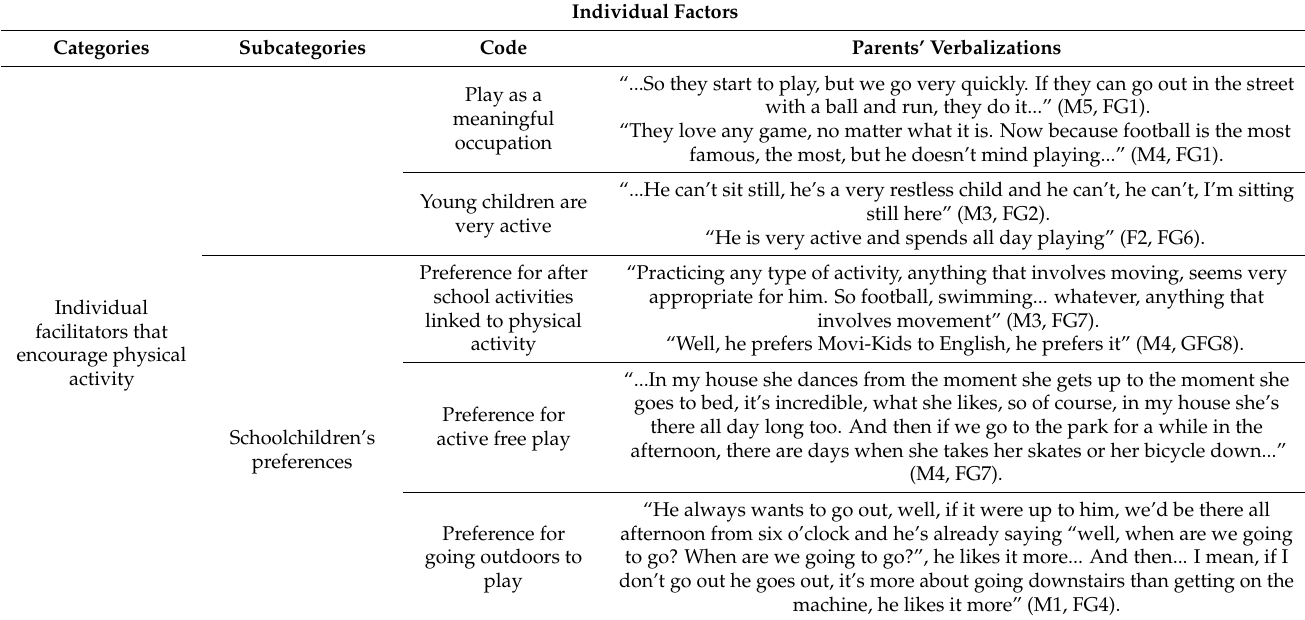
Table 8. Individual factor facilitators for physical activity among